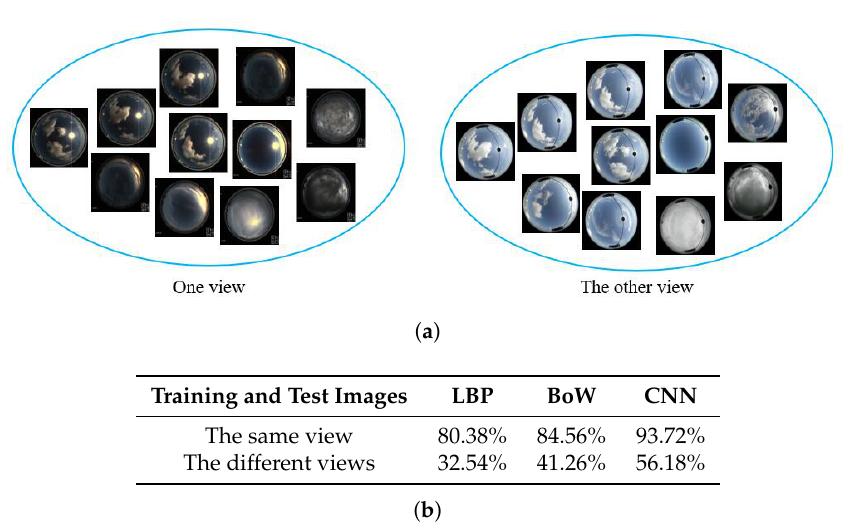
Figure 1. ( a ) We present cloud images from two different views; ( b ) The performance of three competitive methods degrade when presented with view